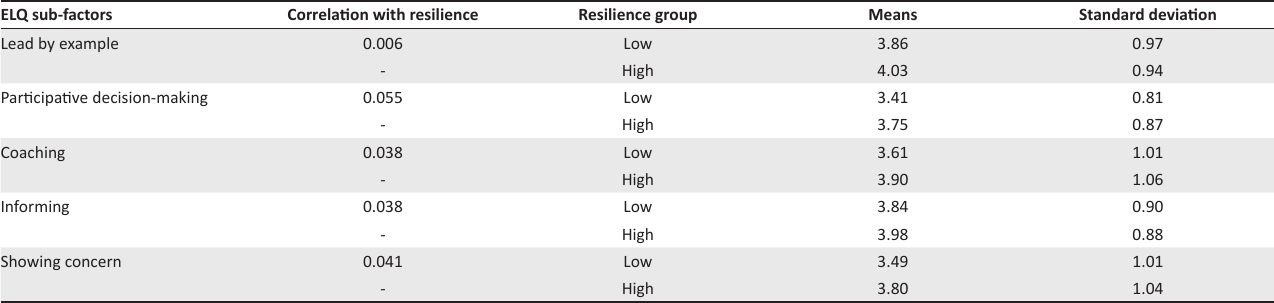
TABLE 5: Results of correlation between resilience and Empowering Leadership Questionnaire (ELQ) as well as Hoteling’s t -test on ELQ sub-scores for high and low resilience groups. ELQ